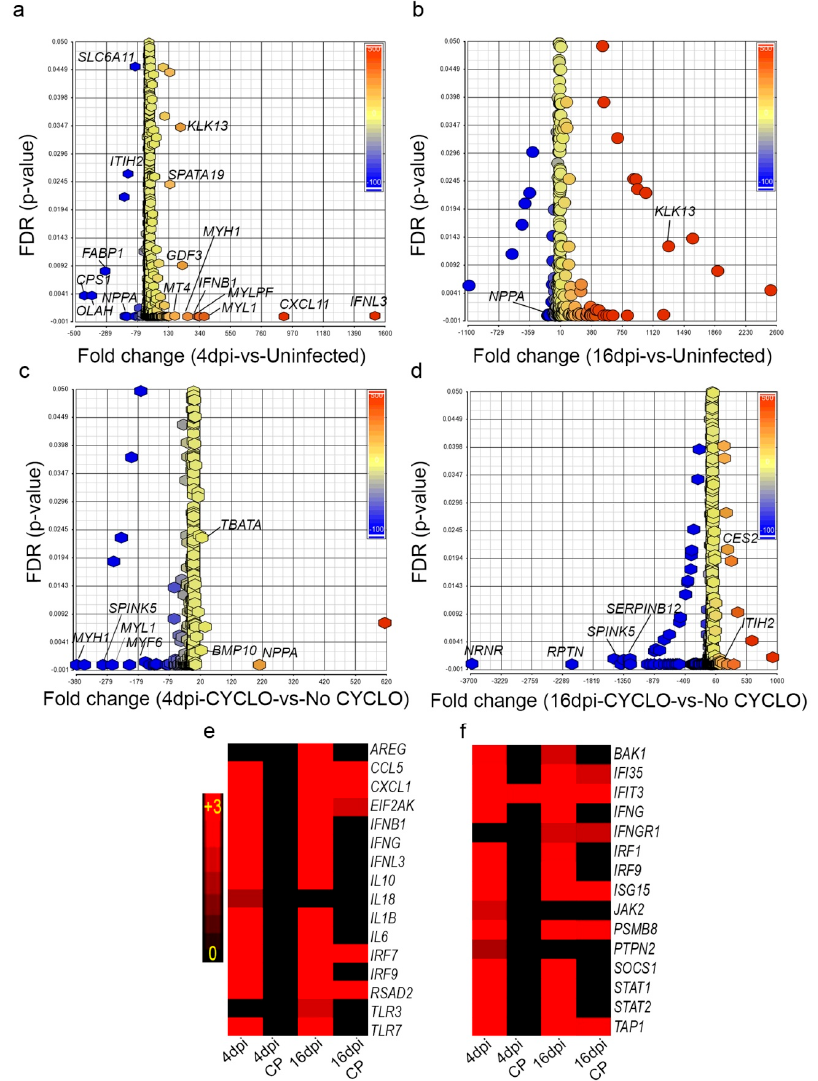
Figure 8. Distribution of differentially expressed genes in immunocompetent and immunocompromised hamsters infected with SARS-CoV-2. ( a ) Scatter plot of SDEG in immunocompetent hamster lungs at 4 dpi. ( b ) Scatter plot of SDEG in immunocompetent hamster lungs at 16 dpi. ( c ) Scatter plot of SDEG in immunocompromised hamster lungs at 4 dpi. ( d ) Scatter plot of SDEG in immunocompromised hamster lungs at 16 dpi. ( e ) Heat-map of SDEG involved in the hypercytokinemia/chemokinemia network. ( f ) Heat-map of SDEG involved in the canonical IFN signaling pathway. Scale bar shows upregulation (red) and no expression (black). FDR—false discovery rate.